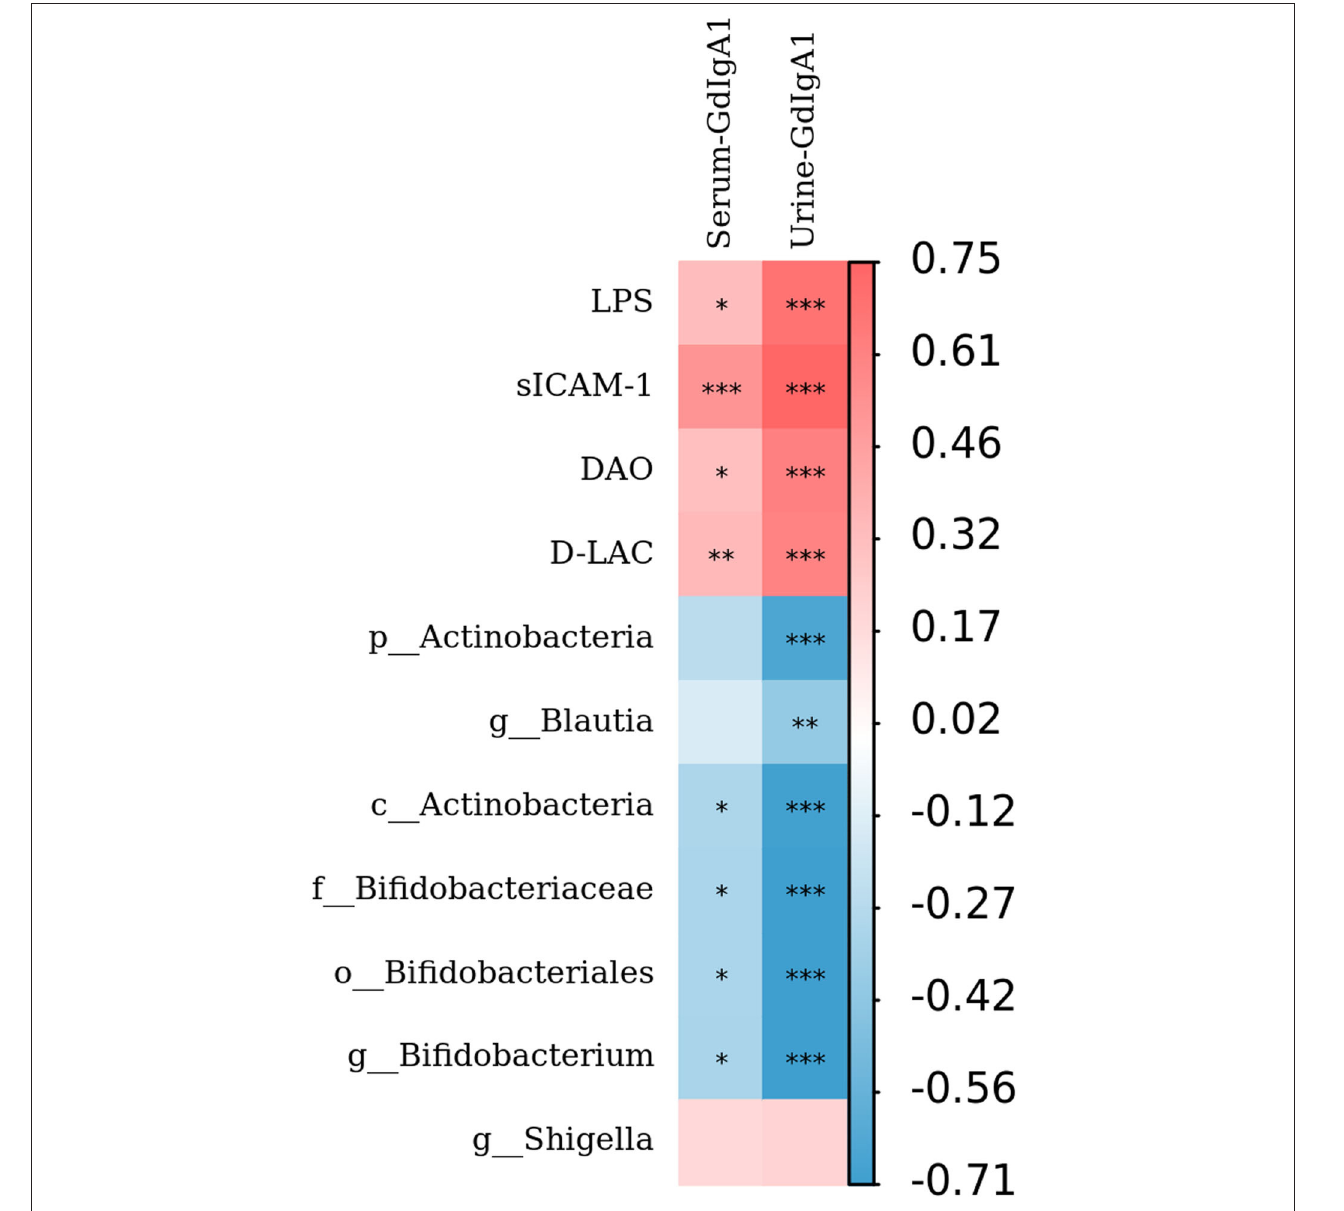
FIGURE 7 | Relationship between Gd-IgA1, intestinal mucosal barrier injury indexes, and bacterial biomarkers. The level of Gd-IgA1, the levels of intestinal mucosal barrier injury indexes (DAO, sICAM-1, D-LAC, and LPS), and bacterial biomarkers in patients with IgAN were analyzed by Spearman correlation analysis. The red square represents the correlation coefficient ( r ) > 0, while the blue square represents the r < 0. * P < 0.05, ** P < 0.01, *** P <